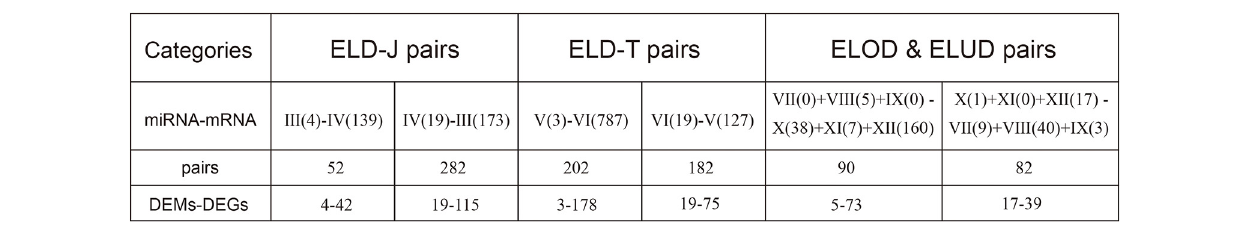
enriched from the ELD-T and ELOD/ELOD pairs genes. By comparing the KEGG pathways enriched from the ELD and ELOD genes with those enriched from ELD pairs and ELOD pairs genes, we found 54.55% (6/11) of the ELD-J pathways, 45.45% (5/11) of the ELD-T pathways (45.45%), and 44.44% (8/18) of the ELOD pathways overlapped with the corresponding miRNA-mRNA pairs pathways ( Supplementary Datasheet 1